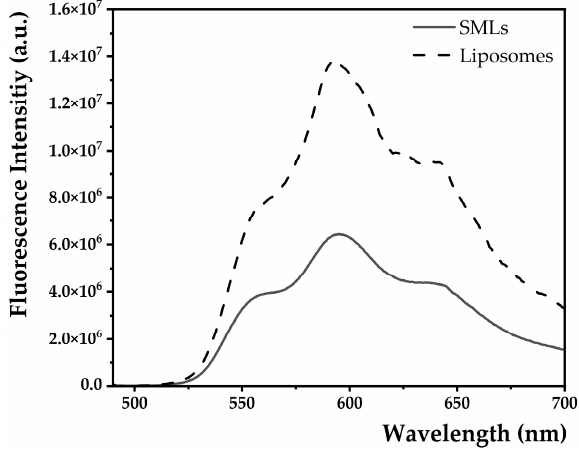
Figure 6. Fluorescence emission spectra ( λ exc = 480 nm) of doxorubicin (1.13 × 10 − 4 M) in DOPE:Ch:CHEMS (45:45:10) SMLs with a magnetic core (solid line) and in liposomes with the same formulation (dashed line).